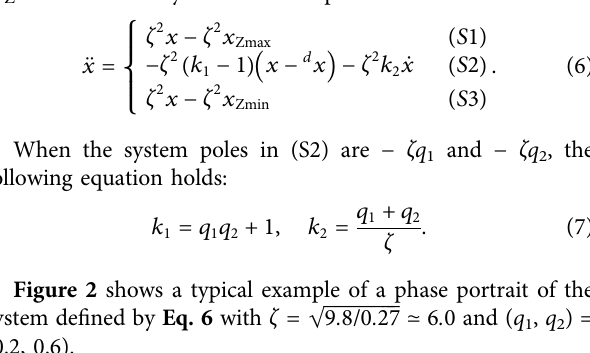
FIGURE 3 | phase portrait of an identi fi ed COM-ZMP regulator from a human ’ s behavior in our previous work (Sugihara et al.,